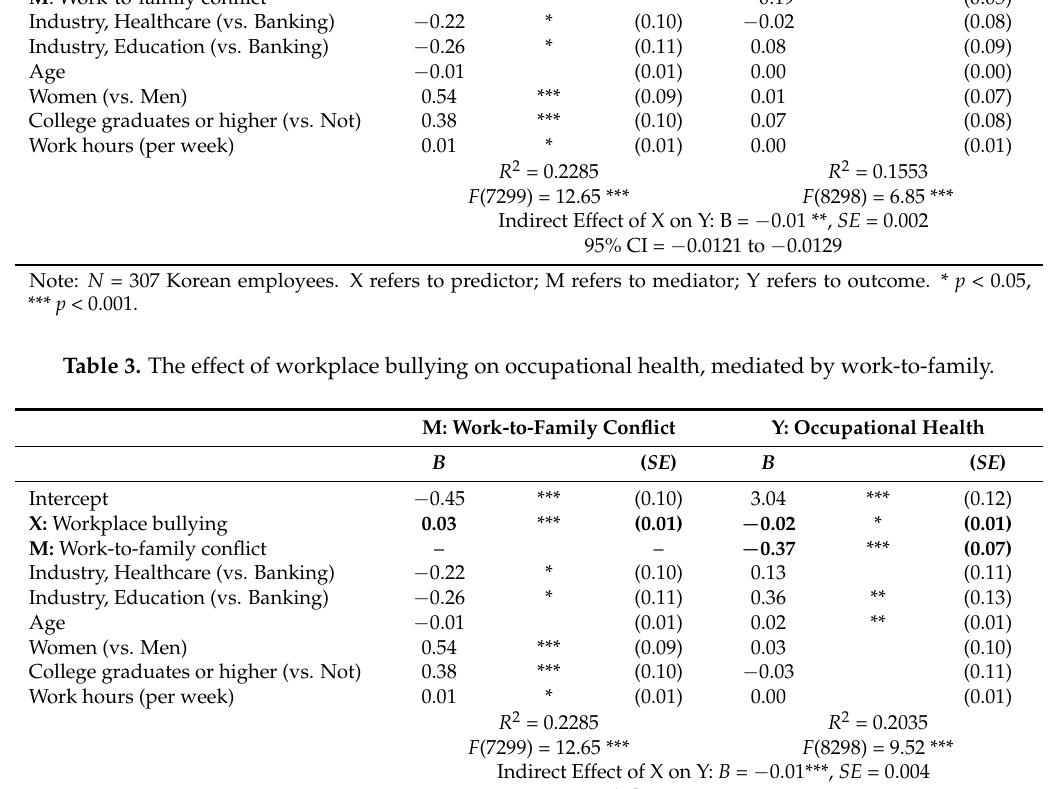
Table 2. The effect of workplace bullying on quality of life, mediated by work-to-family conflict. M: Work-to-Family Conflict Y: Quality of Life Intercept